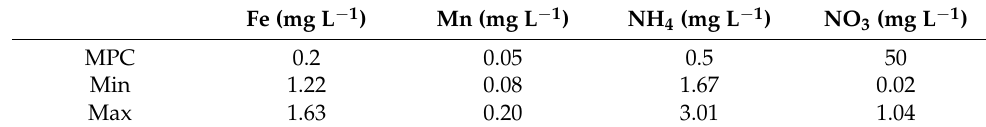
Figure 15. Concentrations of ammonia in groundwater sampled at the Vinogradi pumping station, Osijek, Croatia in the period 1984–2015. Table 3. Concentrations of Fe, Mn, NH 4 , and NO 3 in the period 1984–2015.